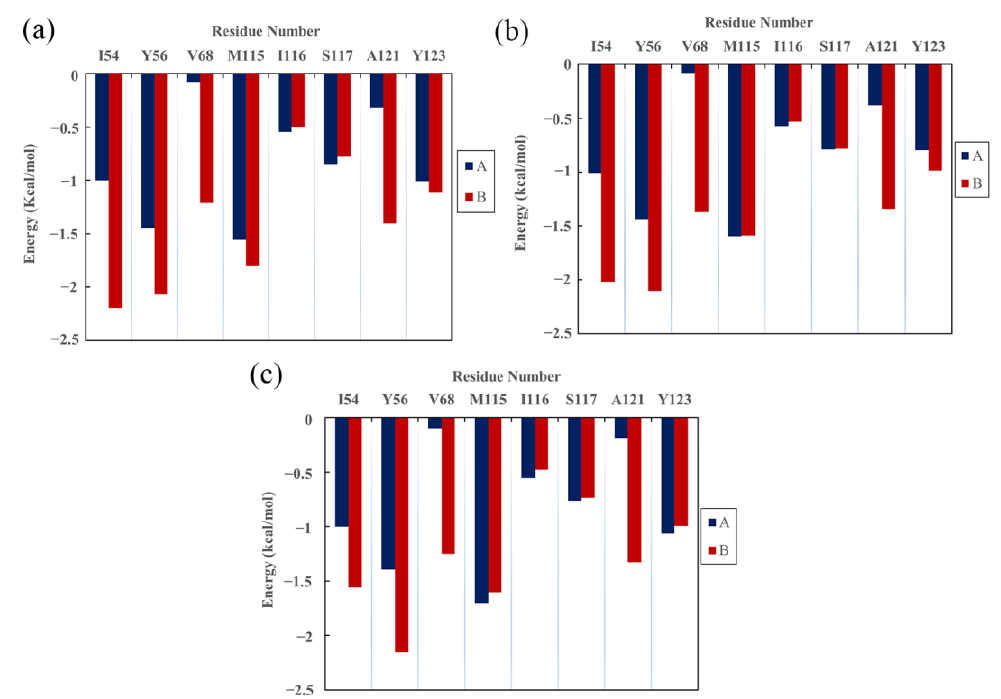
Figure 3. Residue energy decomposition of key residues belonging to the ( a ) MOD, ( b ) S and ( c ) R systems.